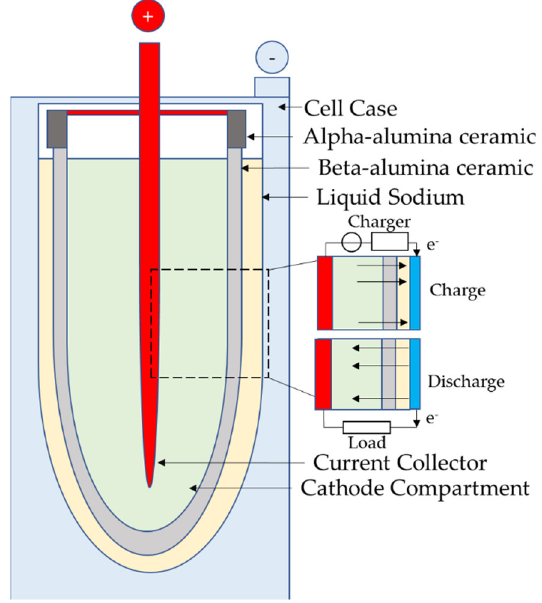
Figure 7. Cell configuration of molten salt batteries.